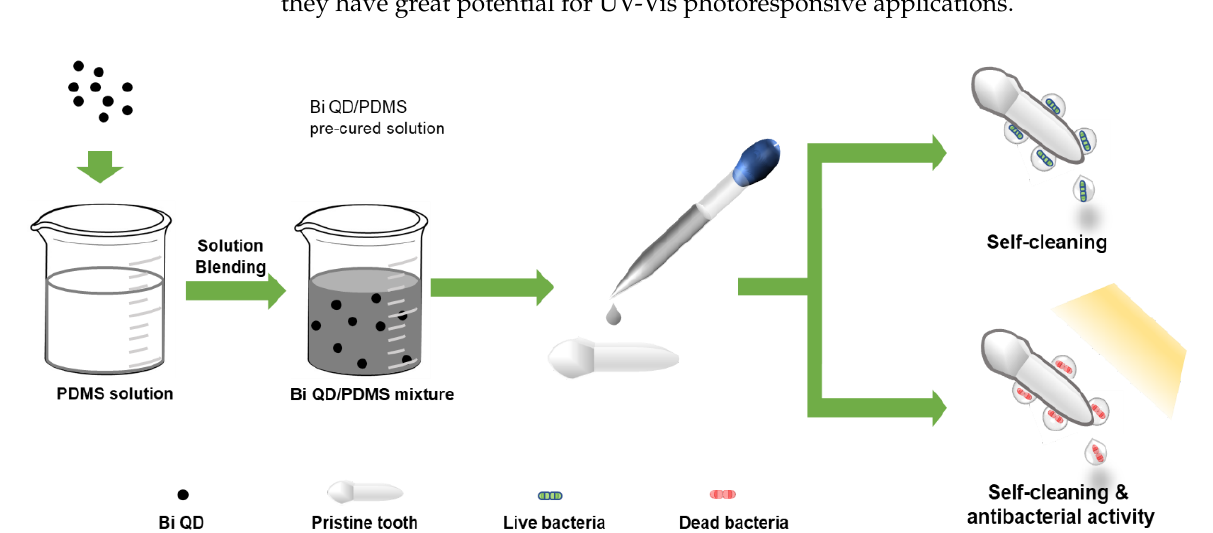
Figure 1. The schematic diagram of the Bi QD/PDMS-modified tooth with both self-cleaning and antibacterial activity.